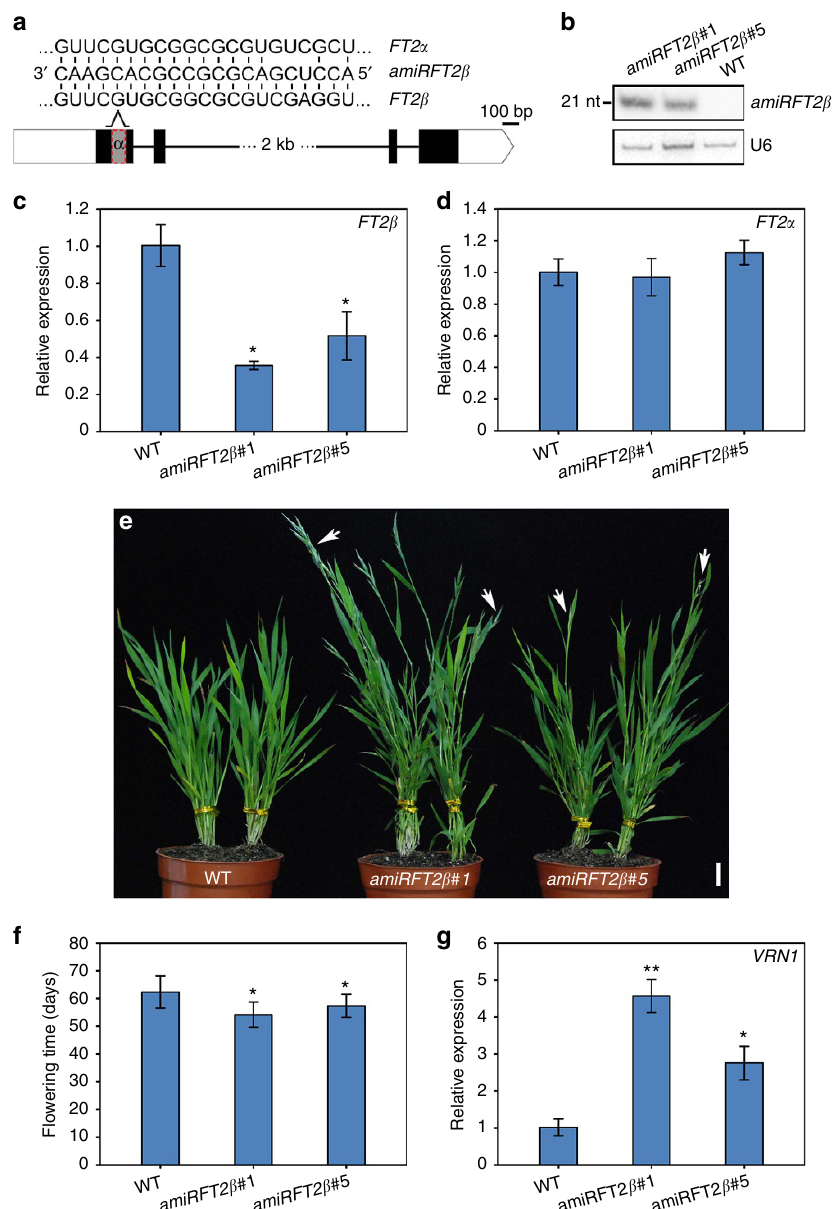
Figure 6 | Interruption of FT2 b activity by artificial miRNA results in early flowering. ( a ) Schematic diagram of amiRFT2 b . ( b ) Northern blotting analysis of artificial miRNA accumulation in amiRFT2 b transgenic plants. U6 was used as a loading control for RNA gel blot. ( c ) qRT-PCR analysis of FT2 b expression in wild-type Bd21-3 and the indicated amiRFT2 b transgenic plants. UBC18 was used as an internal control for normalization of qRT-PCR results. Three six- week-old B. distachyon plants were pooled and collected for RNA isolation. Each qRT-PCR analysis were performed in three biological replicates with similar results. The point represents the mean value of three technical replicates in a representative biological experiment. Error bars indicate s.d. Student’s t -test, * P o 0.05 ( d ) qRT-PCR analysis of FT2 a expression in wild-type and the indicated amiRFT2 b transgenic plants. ( e ) Representative photograph of flowering phenotypes in amiRFT2 b transgenic and wild-type Bd21-3 plants. White arrows point to spikes. Scale bar, 2cm. ( f ) Flowering time of wild-type and the indicated two lines of amiRFT2 b transgenic plants. Error bars indicate s.d. ( n ¼ 10). Student’s t -test, * P o 0.05 ( g ) qRT-PCR analysis of flowering downstream gene VRN1 expression in wild-type and the indicated amiRFT2 b transgenic plants. Total RNA from 5-week-old whole-plant tissues, including leaves and shoot apex, were used for VRN1 examination. Student’s t -test, ** P o 0.01, * P o